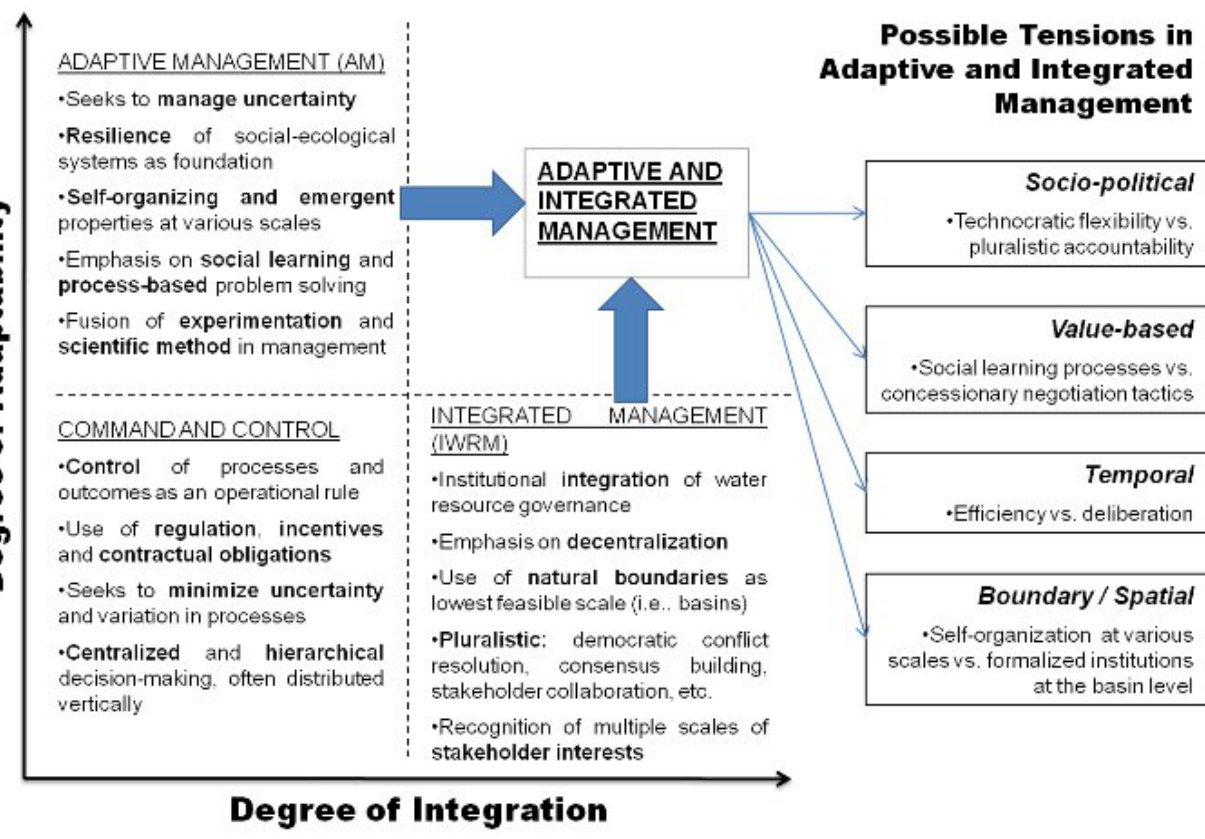
Fig. 1. A simplified summary of major integrated water resources management (IWRM) and adaptive management (AM) principles, and some potential tensions from merging the two